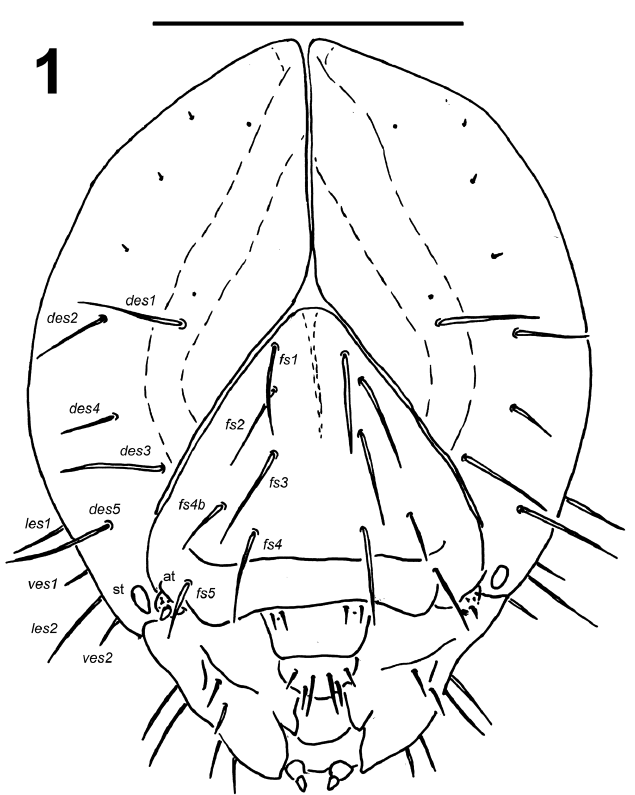
Figure 1. Larinus vulpes mature larva head, frontal view. Abbreviations: des – dorsal epicranial s., fs – frontal epicranial s., les – lateral epicranial s., ves – ventral epicranial s., at – antenna, st – stemma. Scale bar 1 mm.